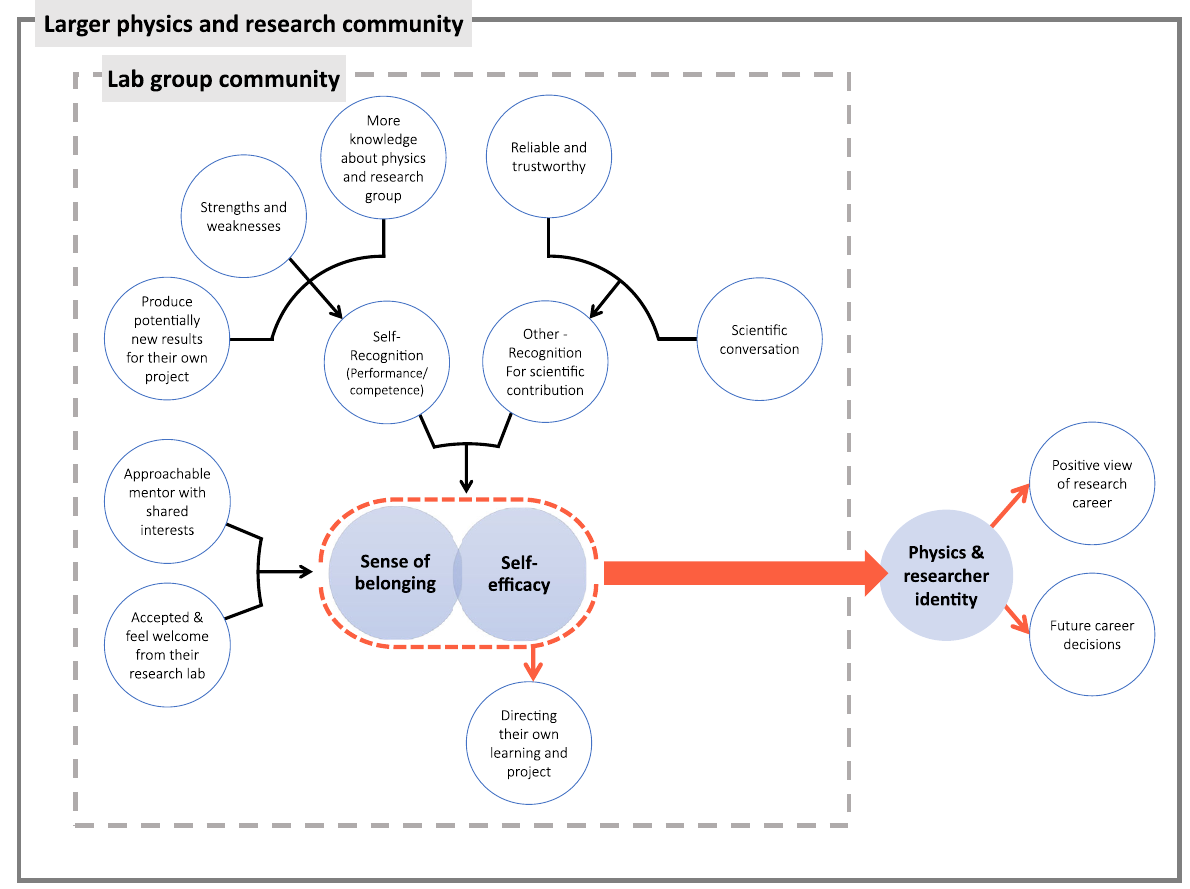
FIG. 5. Various factors contributing to boost SOB and self-efficacy and, respectively, physics and researcher identity and SOB to the larger physics and research